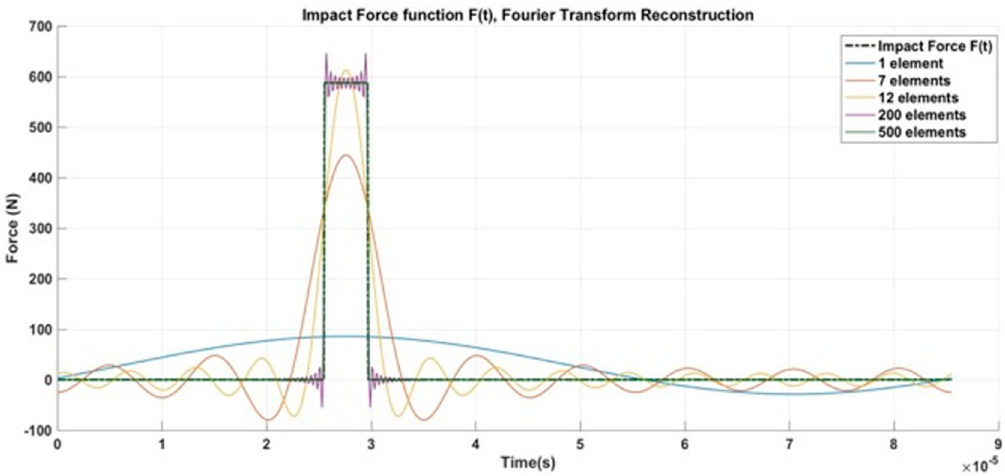
Figure 11. Impact force step wise definition and its corresponding Fourier Reconstruction (where impact duration depends on droplet diameter and the peak value depends on the velocity of droplet impact and liquid-coating relative impedances).